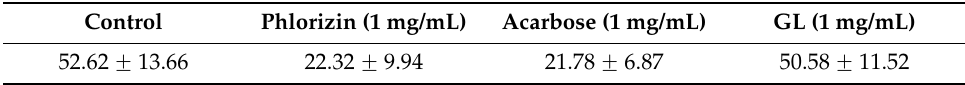
Table 4. Effect of an ethanolic extract of Gongronema latifolium on glucose active transport via isolated rat jejunum ( n = 6).